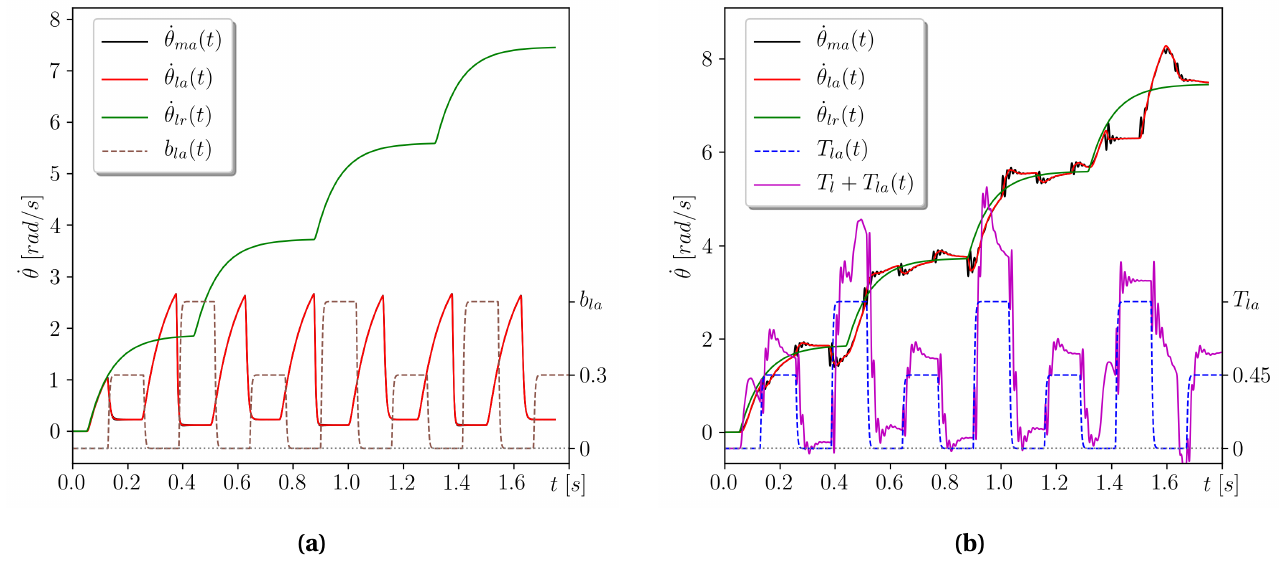
Figure 11. The closed-loop reference model control system response at the presence of the disturbed b la ( t ) ( a ) and T la ( t ) ( b ) and a FOPID regulator (high frequency) – see case B in the block diagram in Figure 3.